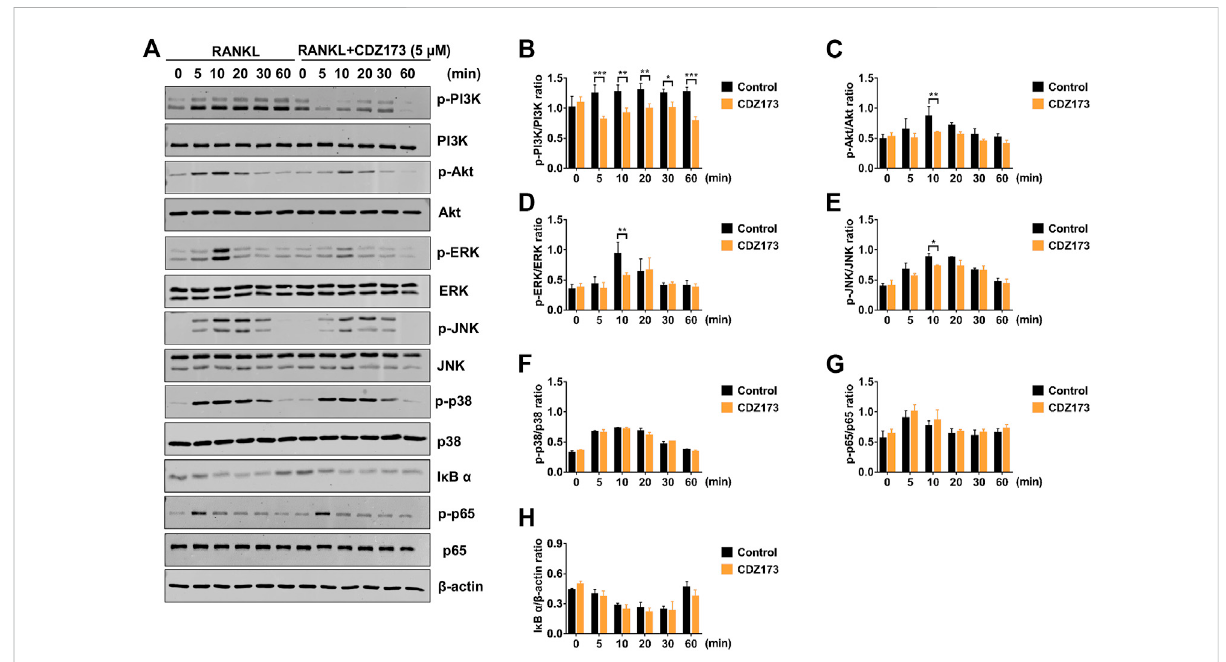
FIGURE 7 CDZ173suppressedRANKL-inducedPI3K-AKT andMAPKs butnotNF- κ Bsignaling pathways. (A) BMMswerepretreatedfor4 hwithorwithout 5 mM CDZ173, then stimulated for the given durations with RANKL (30 ng/ml). Cells were lysed, total proteins were extracted and subjected to western blot analysis using speci fi c antibodies against p-PI3K, total PI3K p-AKT, total AKT, p-ERK, total ERK, p-JNK, total JNK, p-p38, total p38, p-p65, total p65 and I κ B α . Antibody against β -actin was used as internal loading control. The relative densitometry of protein bands for (B)